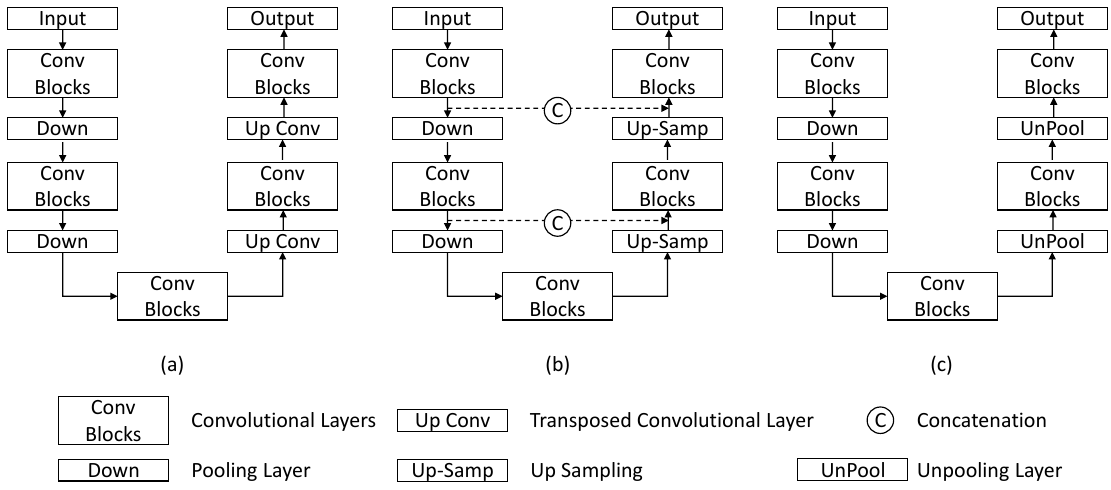
Figure 3. General architectures of three common state-of-the-art deep-neural networks-based models for semantic segmentation. ( a ) Fully Convolutional Network (FCN) [11], ( b ) U-net [12], and ( c ) SegNet